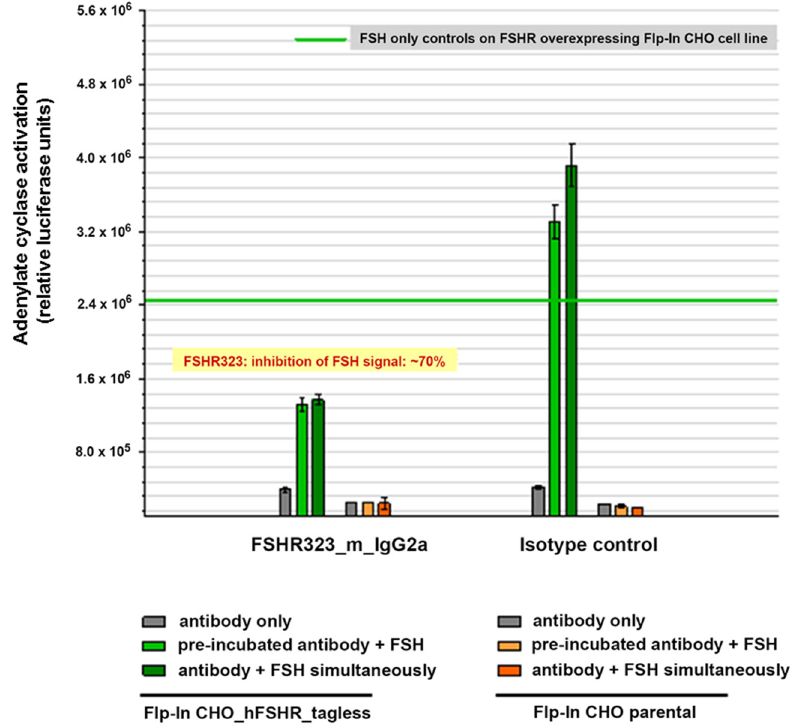
Figure 4. Cyclic AMP signaling in response to FSH after pre-incubation with isotype control IgG and FSHR323 antibody. Flp-In CHO/FSHR cells expressing the recombinant hFSHR were plated and incubated with various concentrations of monoclonal antibodies in DMEM and 0.5 mM 3-Isobutyl-1-methylxanthin (IBMX). FSH (1.65 nM) was added. Cyclic AMP was measured by cAMP reporter gene assay (see Section 4). FSHR323 inhibited cAMP ‐ dependent signaling in response to FSH.